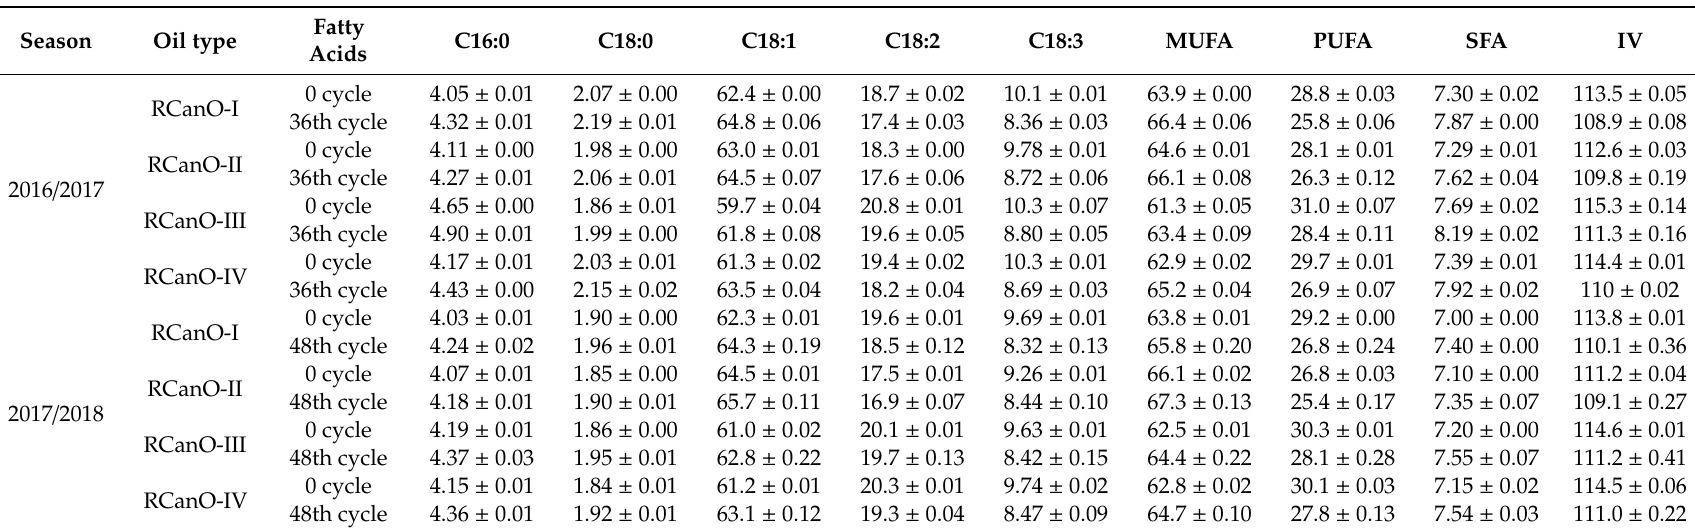
Table 2. Fatty acids composition of canola oils from the 2016 / 2017 and 2017 / 2018 production